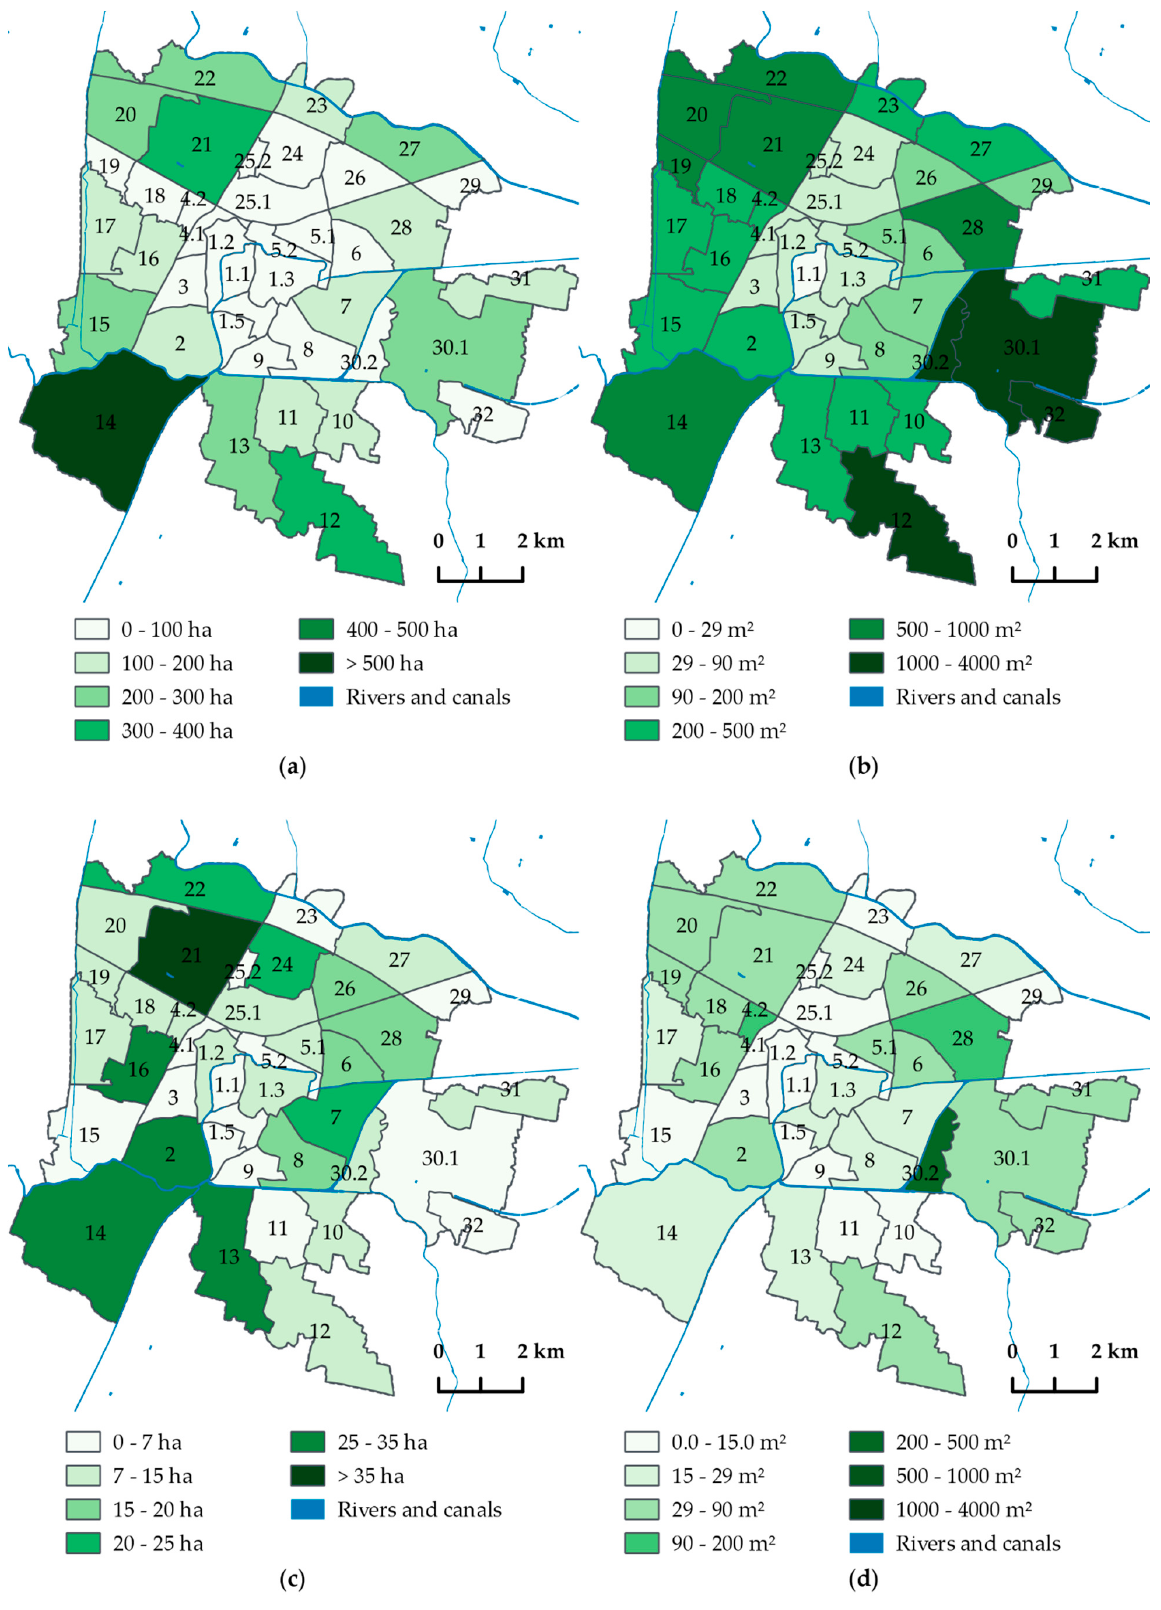
Figure 13. Spatial analyses of urban green space and population at sub-neighbourhood urban unit levels: ( a ) map of total urban green spaces; ( b ) map of urban green spaces per capita; ( c ) map of municipal urban green spaces; ( d ) map of municipal urban green spaces per capita.